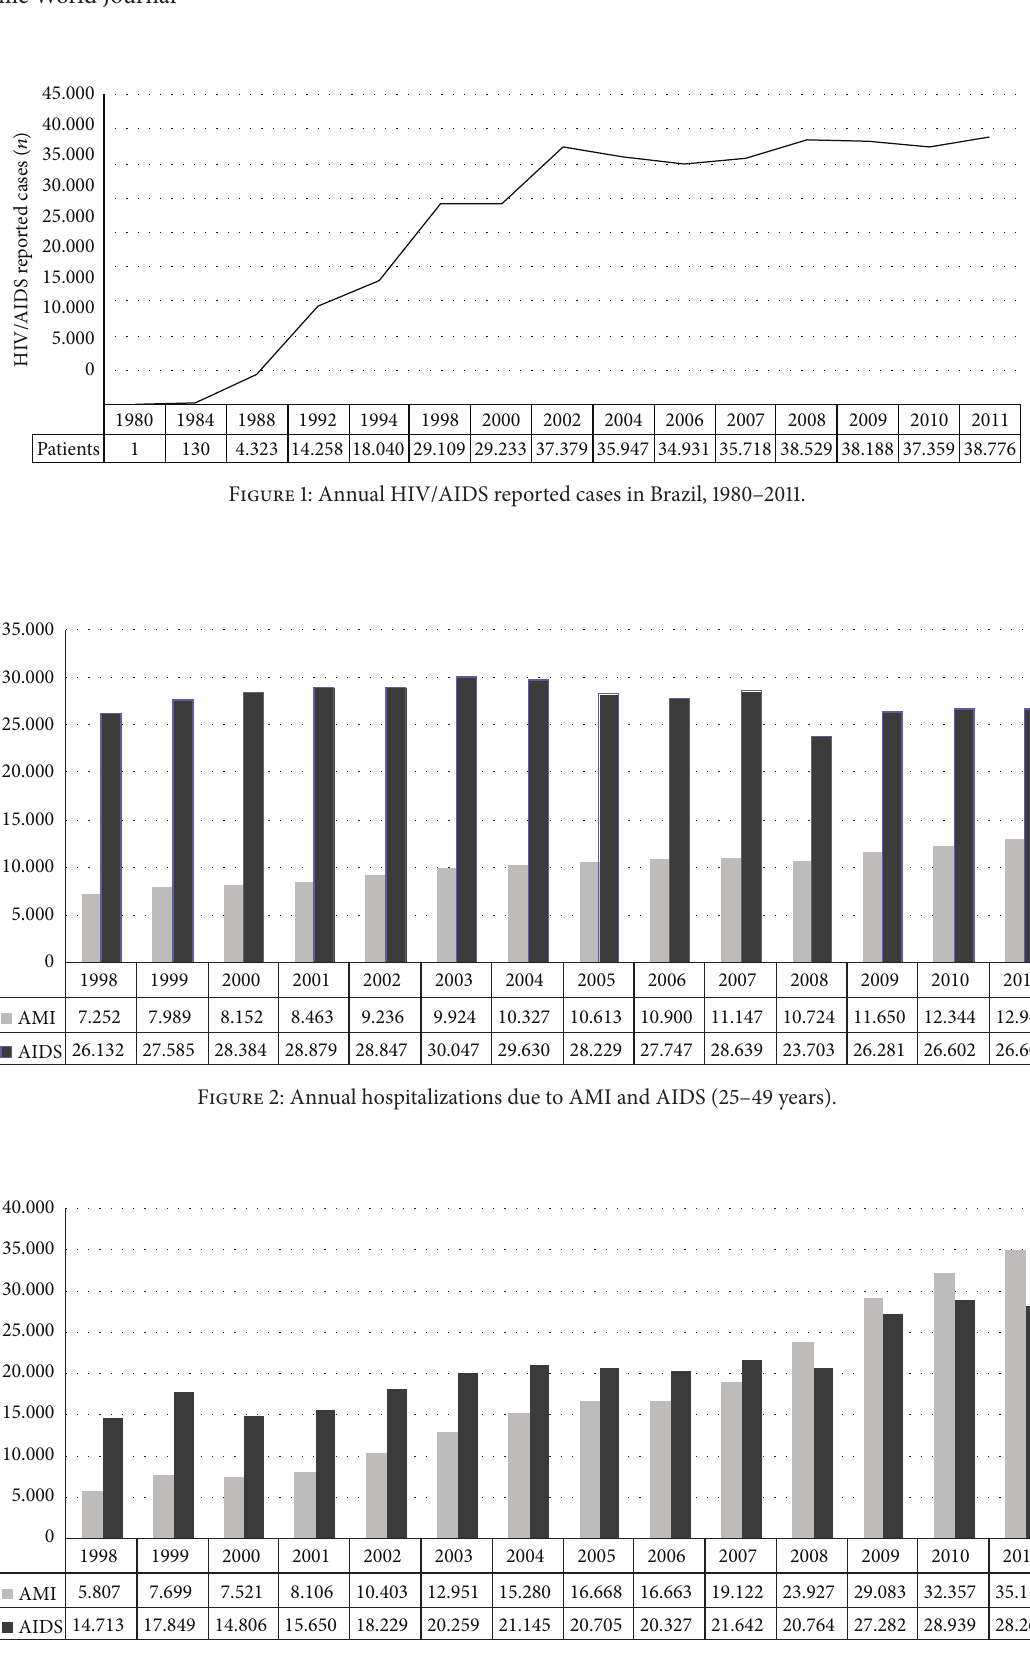
Figure 3: Annual costs with AMI and AIDS hospitalizations (25–49